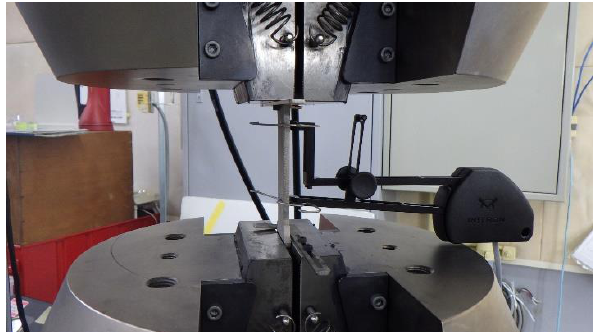
Figure 1. Tensile test setup with the additively manufactured structure using Ti6Al4V.